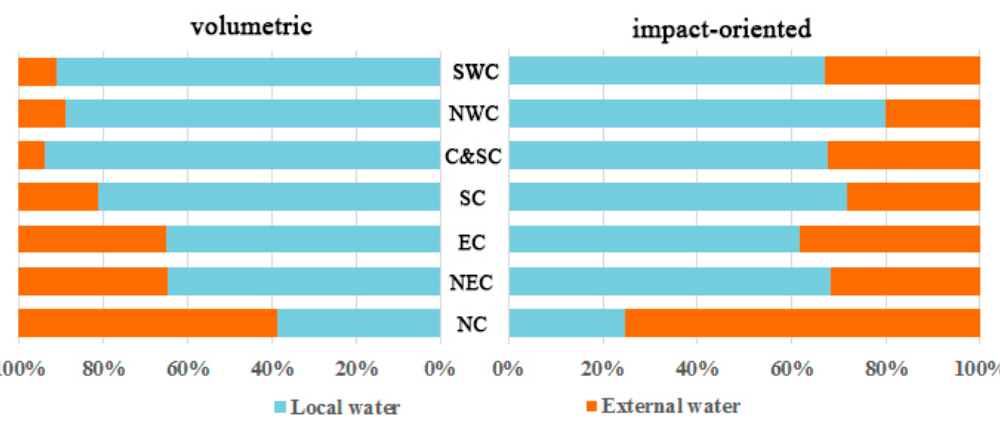
Figure 1. Regional agricultural water consumption.